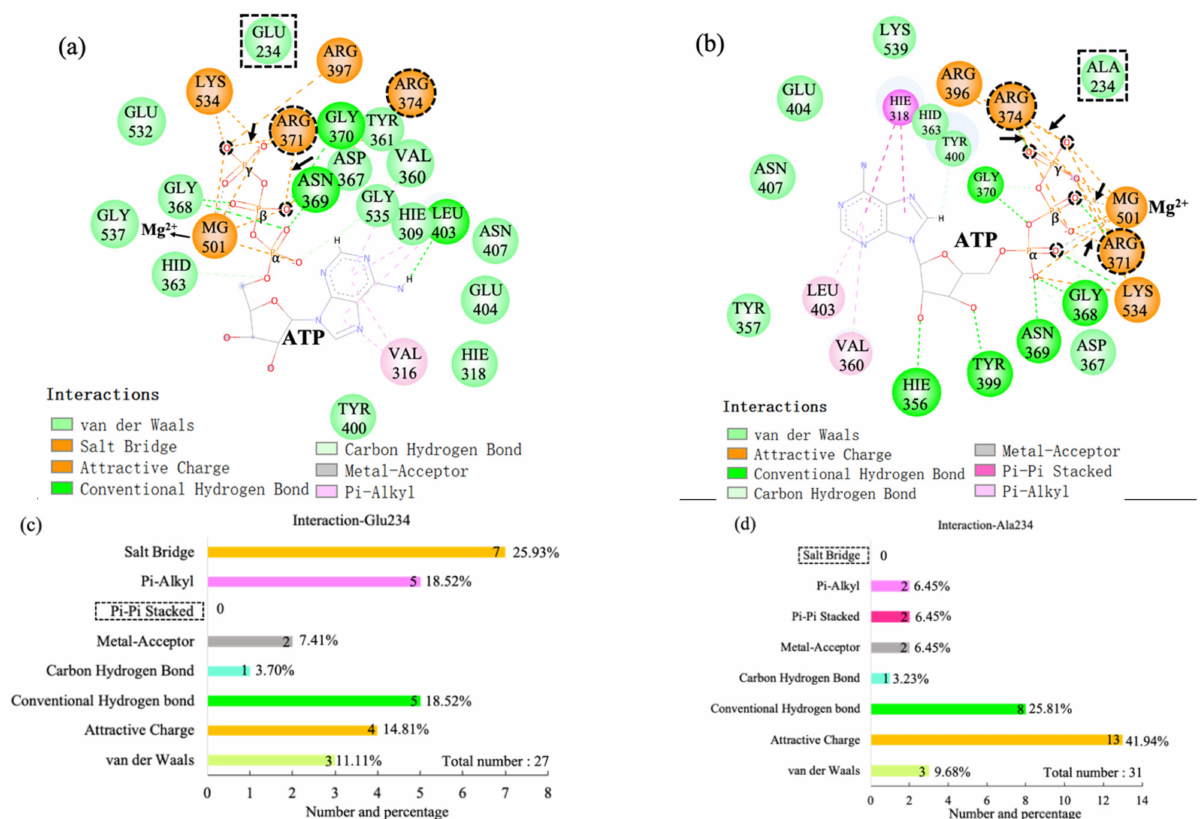
Figure 3. Interaction maps for HYPE protein complexed with BiP protein, obtained from equilibrated structures. ( a ) for Glu234; ( b ) for Ala234; ( c ) represents the analysis details of interaction of Glu234 in ( a ); ( d ) represents the analysis of interaction of Ala234 in ( b ). The black arrow in ( a , b ) are the interaction between Arginine residue and ATP. ( a , b ) made by Discovery Studio Visualizer, and ( c , d ) were obtained by the excel